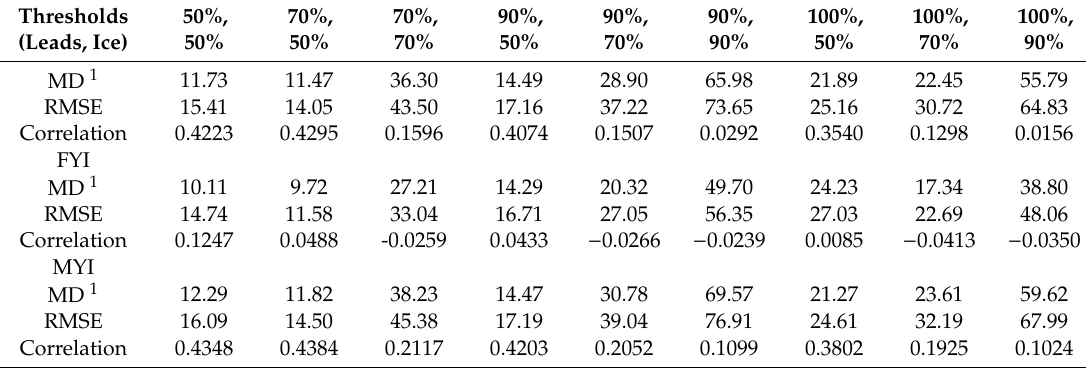
Table 3. Retrieved sea ice freeboard using BCF with di ff erent retracking thresholds, compared with the freeboard determined from OIB March 2014 data for overall, FYI, and MYI separately. Unit: